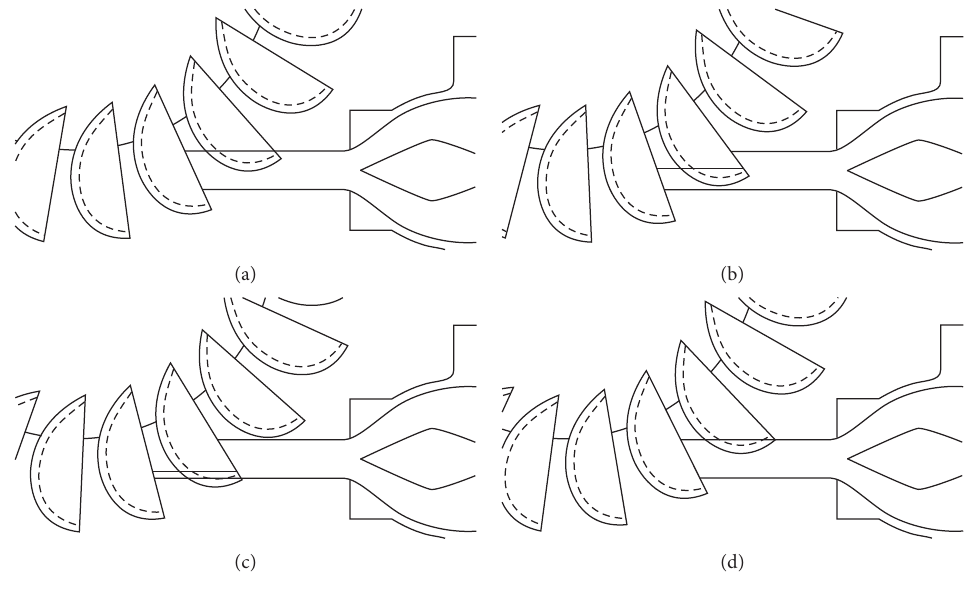
Figure 7: Bucket relative position to water